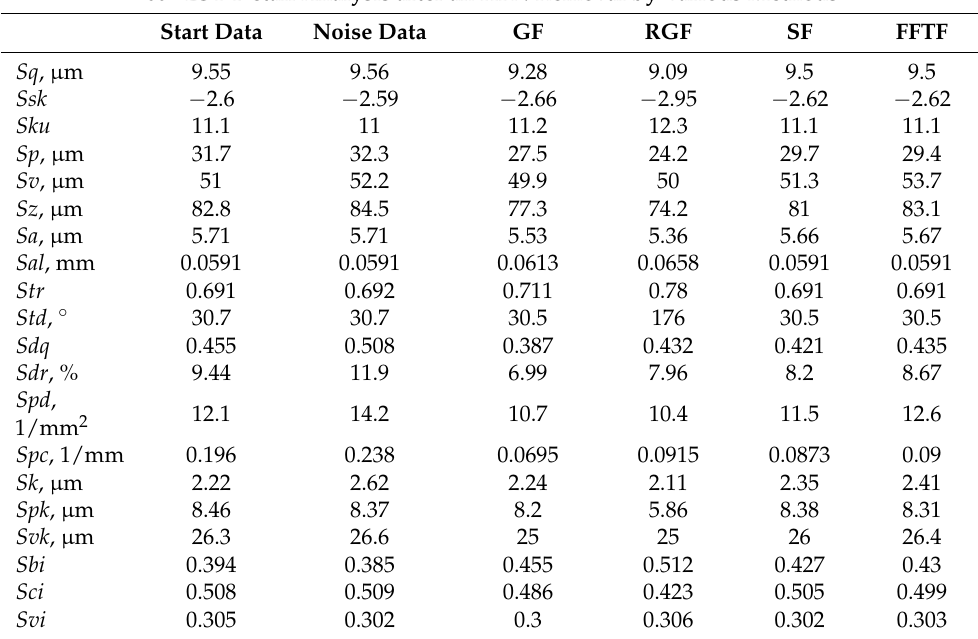
Table 2. Values of surface topography parameters, from ISO 25178 standard, defined for a primary surface data (start data), containing an HFN (noise data) and after reduction in HFN by various methods: GF, RGF, SF and FFTF, cut-off = 0.025 mm.